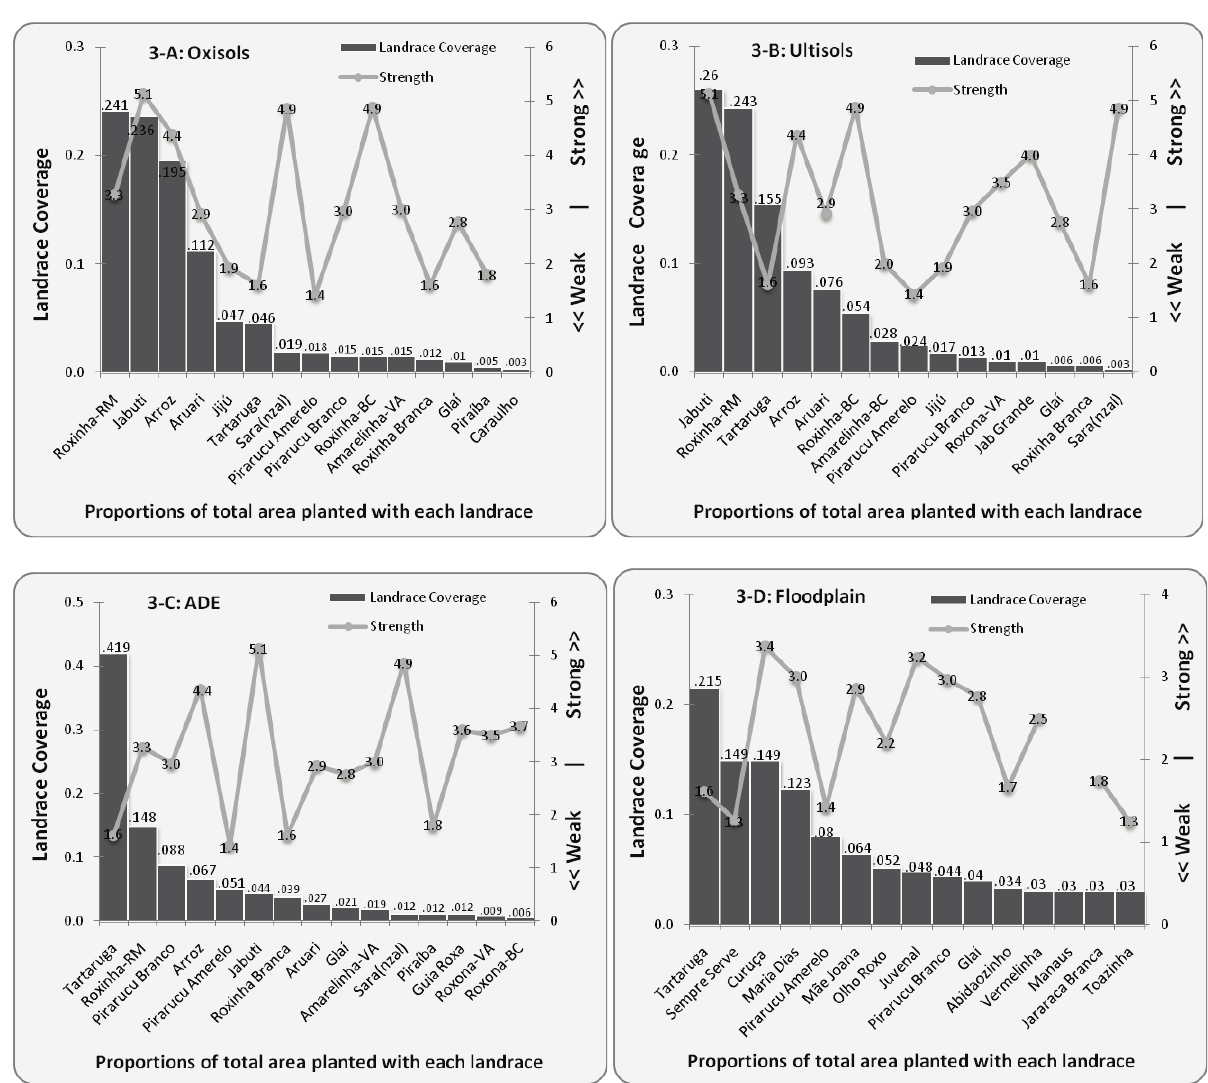
Figure 3. Total Landrace Coverage and relative Strengths of the 15 bitter manioc varieties that are most predominant in 64 Oxisol fields (3-A), 55 Ultisol fields (3-B), 71 ADE fields (3-C), 59 floodplain fields (3-D) along the middle Madeira